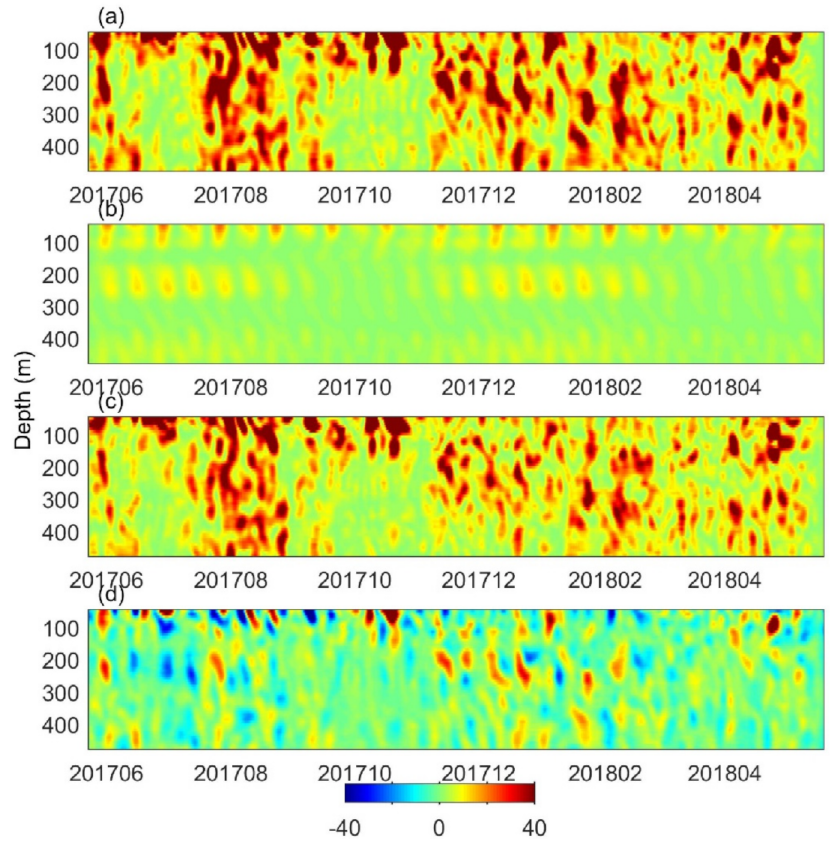
Figure 5. The horizontal kinetic energy values (HKEs; unit: J m − 1 ) of diurnal currents ( a ) and their coherent component ( b ), incoherent component ( c ) and cross-term ( d